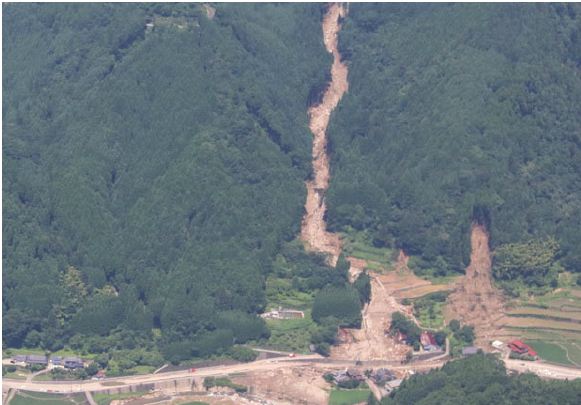
Figure 17. Sediment disasters in Asakura City